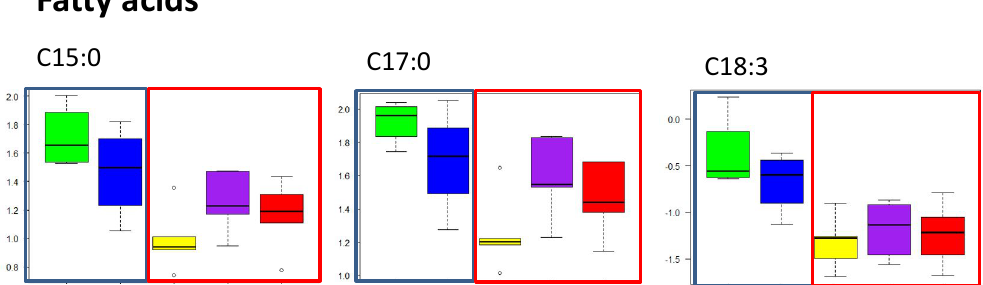
Figure 5. Box plots showing the abundance of some free fatty acid metabolites in the livers of female sand flathead collected from five sites ( n = 3–6 fish per site) in Port Phillip Bay, Victoria, Australia in March 2015. Green = Sorrento, blue = St Leonards, yellow = Corio Bay, purple = Mordialloc, and red = Hobsons Bay. Blue outline represents rural sites; red outline represents urban